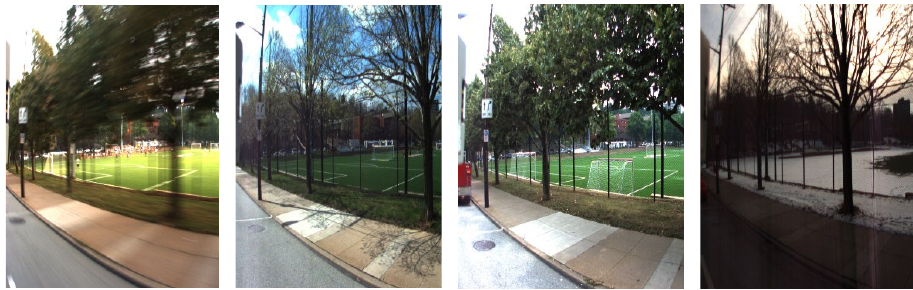
Figure 12. The same place during different seasons of a year from the CMU dataset.